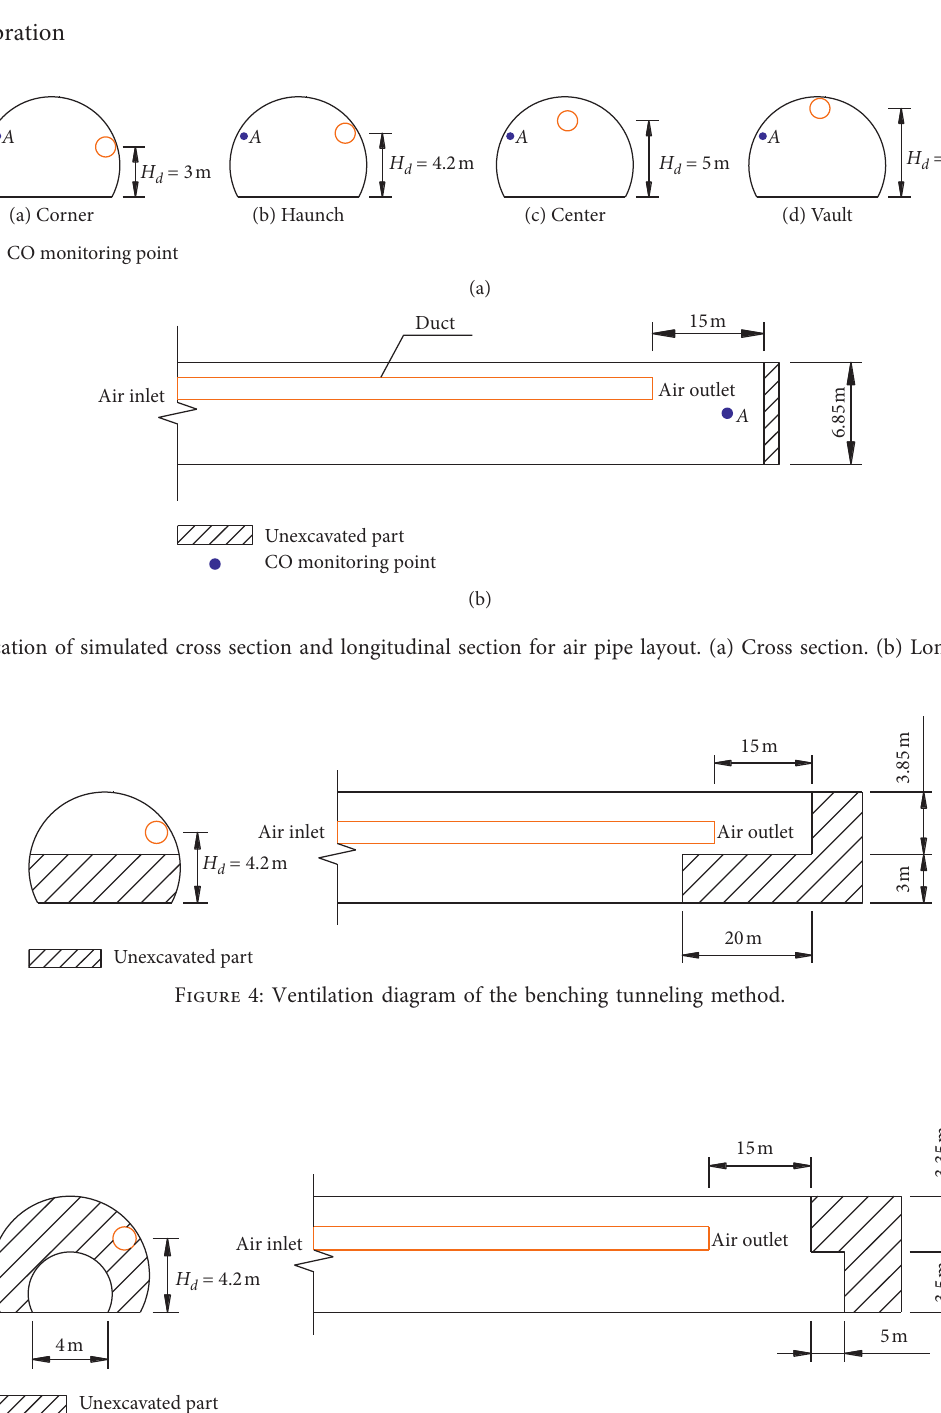
Figure 5: Schematic diagram of ventilation under the lower pilot heading method.